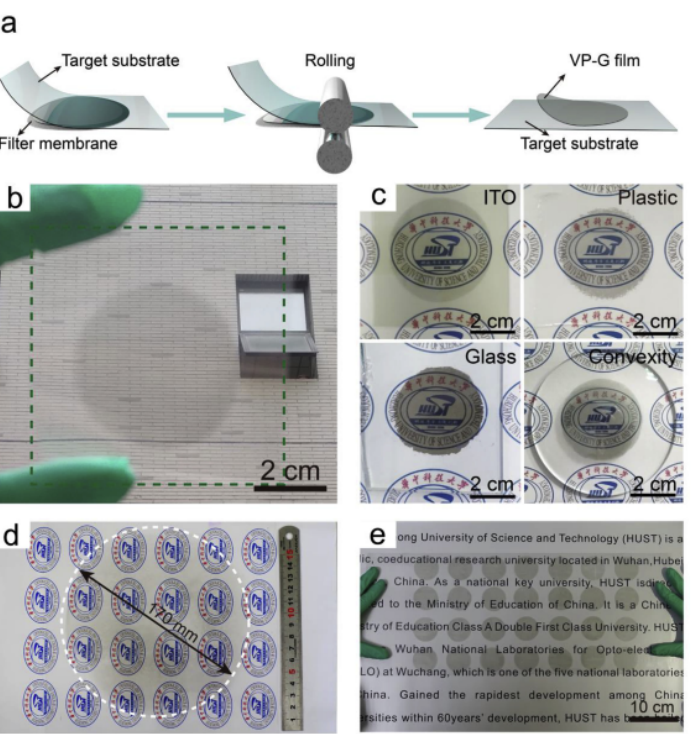
Figure 3. ( a ) Illustration of the transfer of the VrG film onto a substrate via a rolling process. Digital photographs of ( b ) transparent VrG films with a thickness of 22 nm, ( c ) transparent VrG on ITO, plastic, and glass with good convexity, and ( d ) a large VrG disc pressed on a substrate. ( e ) Digital photograph of a 7 × 4 array of the large-scale VrG films. Reprinted with permission from Ref.